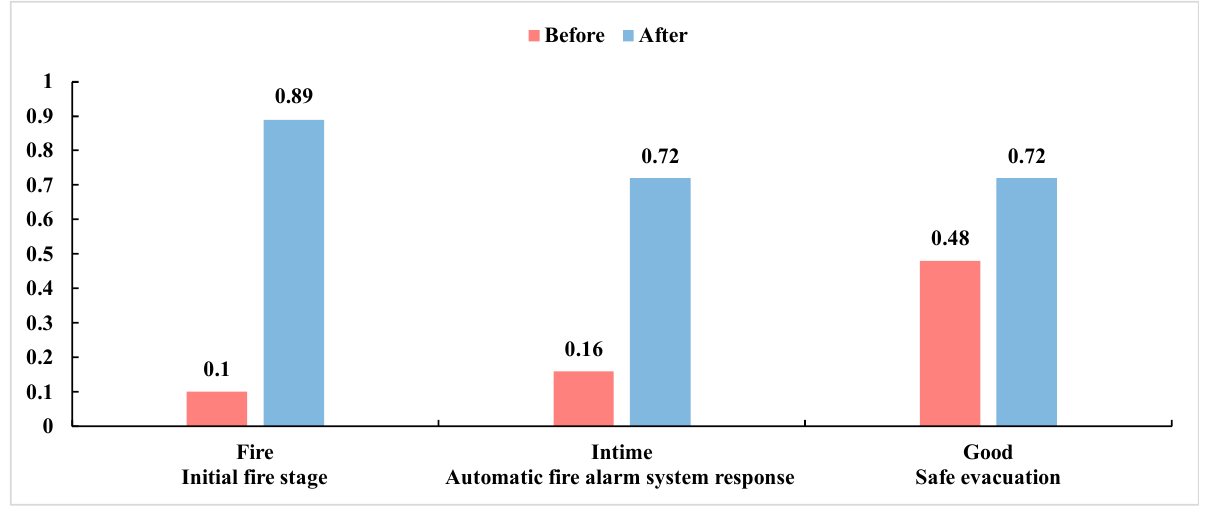
Figure 10. Probabilities before and after Scenario 1 occurrence.